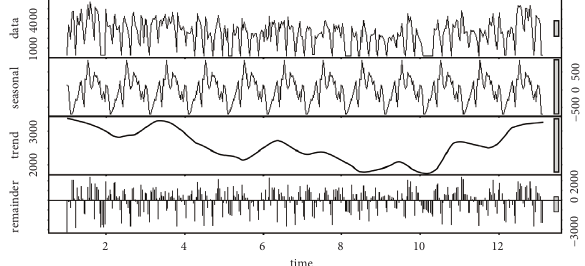
Figure 15: Diagram showing decomposed data in the year 2017.